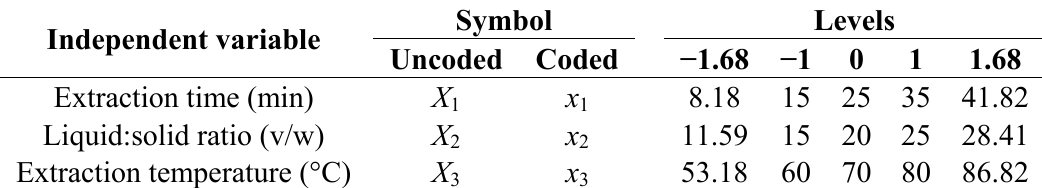
Table 4. Independent variable values of the process and their corresponding